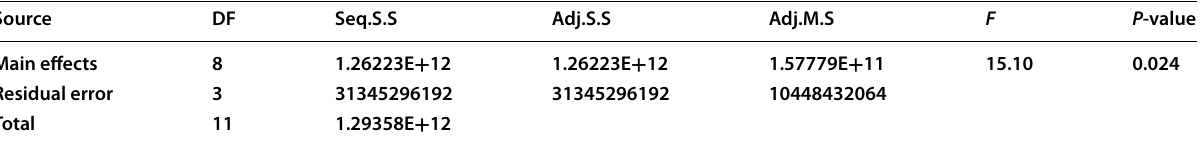
Table 6 ANOVA for a quadratic model of BL for V . sp.